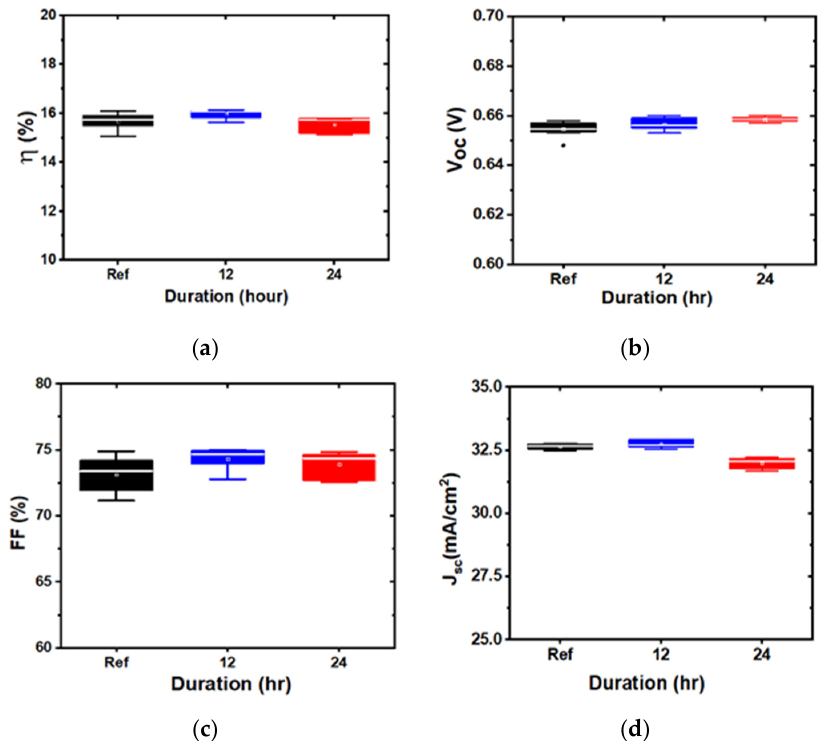
Figure 4. Box plots of device parameters for indium tin oxide (ITO) deposited at 3 mTorr, soaked for different durations: ( a ) efficiency; ( b ): open circuit voltage; ( c ): fill factor; and ( d ): short circuit current density.